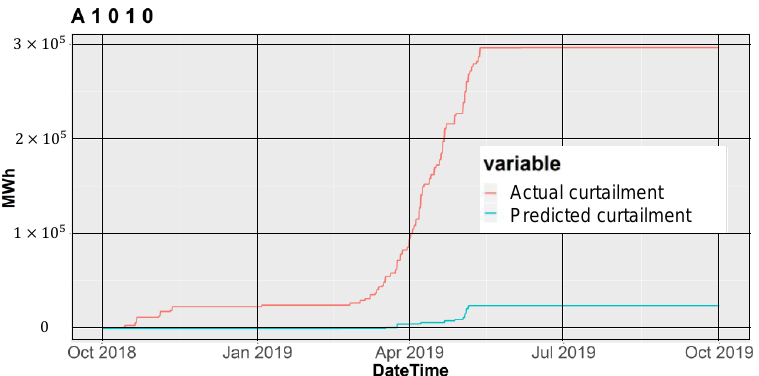
Figure 8. Comparison between uncalibrated cumulative curtailment forecast (blue line) and actual cumulative curtailment (red line) from October 2018 to September 2019.